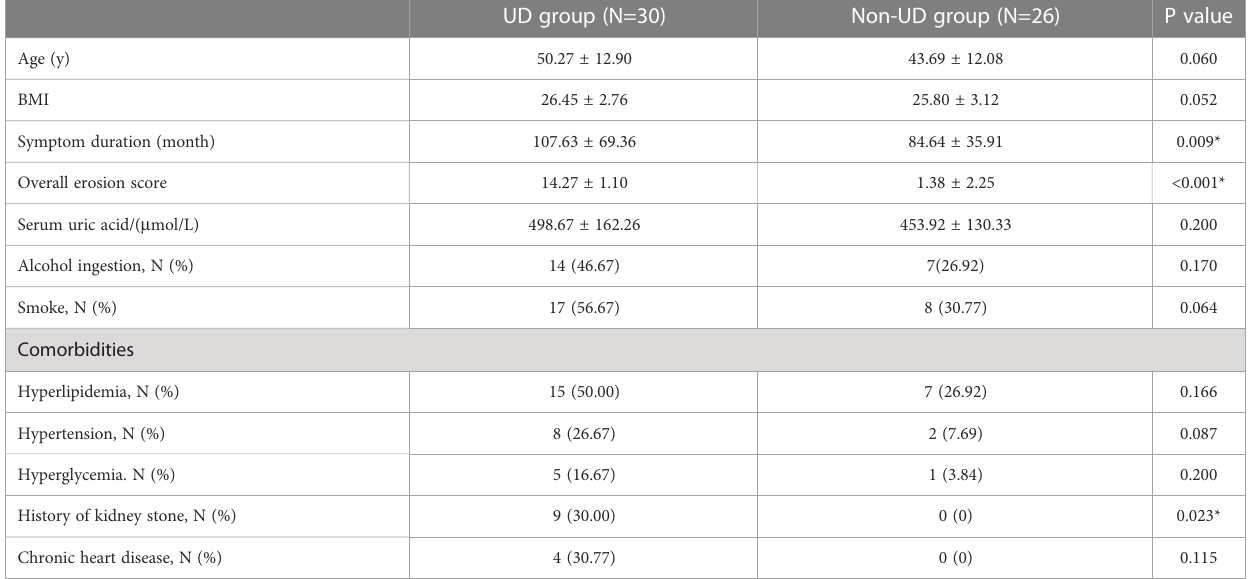
TABLE 1 Comparison of patient characteristics in the UD and non-UD